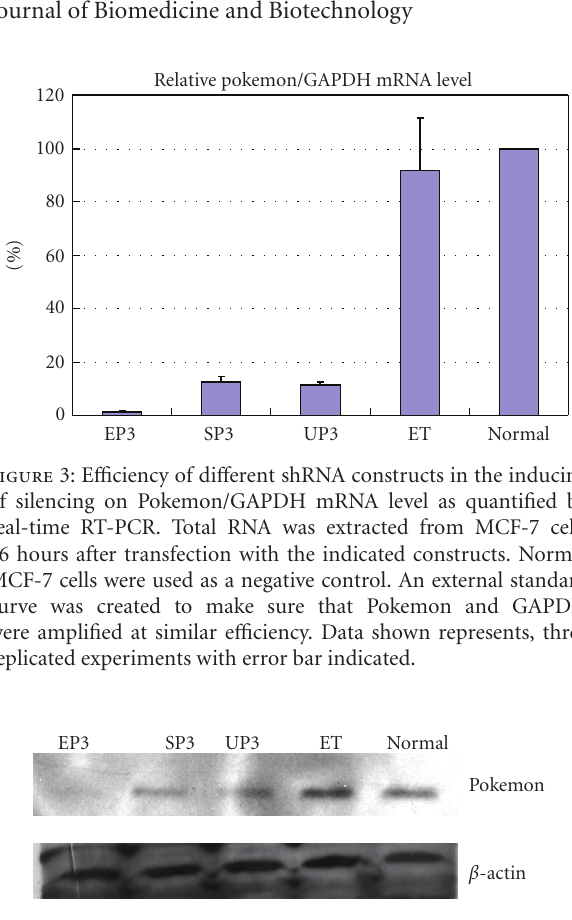
Figure 4: E ffi ciency of di ff erent shRNA constructs in the inducing of silencing of endogenous gene expression. The western blot shows the Pokemon bands and the β -actin bands which serve as an endogenous control.